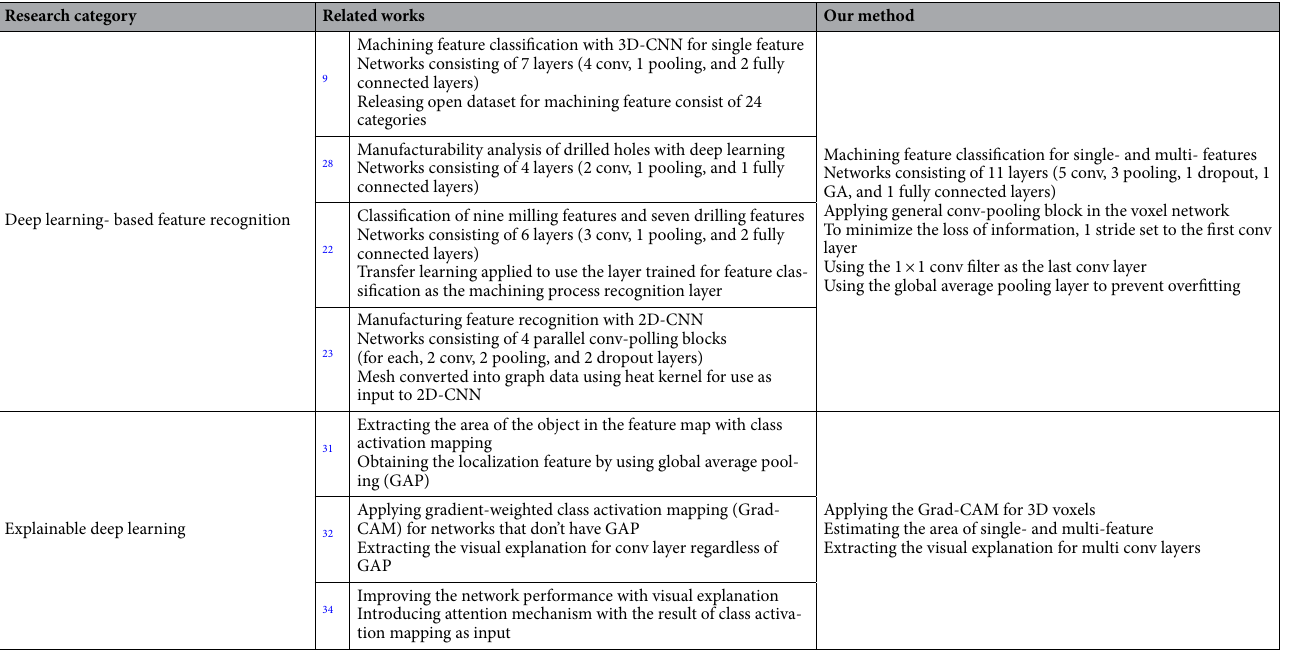
Table 1. Comparison between our method and related